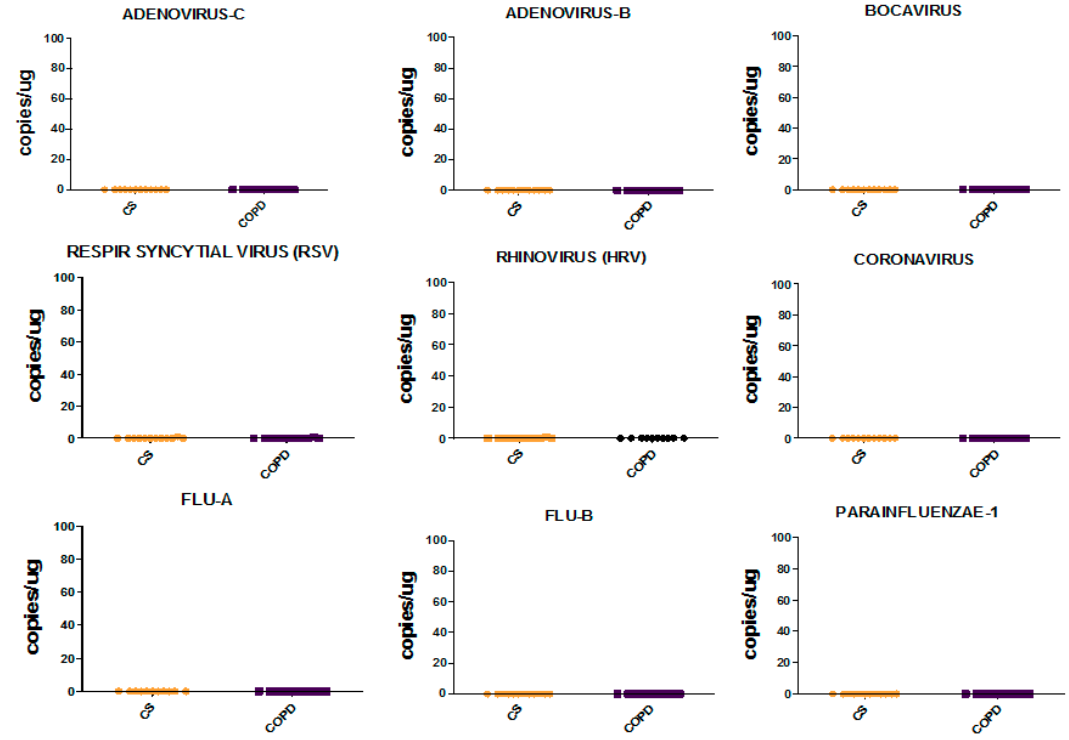
Figure 3. Individual values for viral load in lung parenchyma of control smokers (CS) and COPD patientsquantified byRT-PCR.Horizontal barsare medianvalues. Dataarereportedascopies / µ gof lung parenchymal tissue examined for Adenovirus-C, Adenovirus-B, Bocavirus, Respiratory Syncytial Virus (RSV), Rhinovirus (HRV), Coronavirus, Flu-A, Flu-B and Parainfluenzae-1. Results are representative of those from 12 subjects with stable COPD and 12 control smokers with normal lung